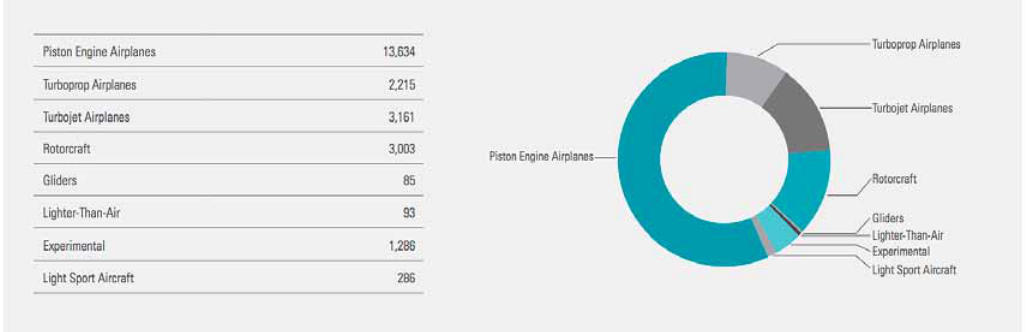
Fig. 3. Total amount of flight hours of piston engine airplanes in North American market. From (GAMA 2010)